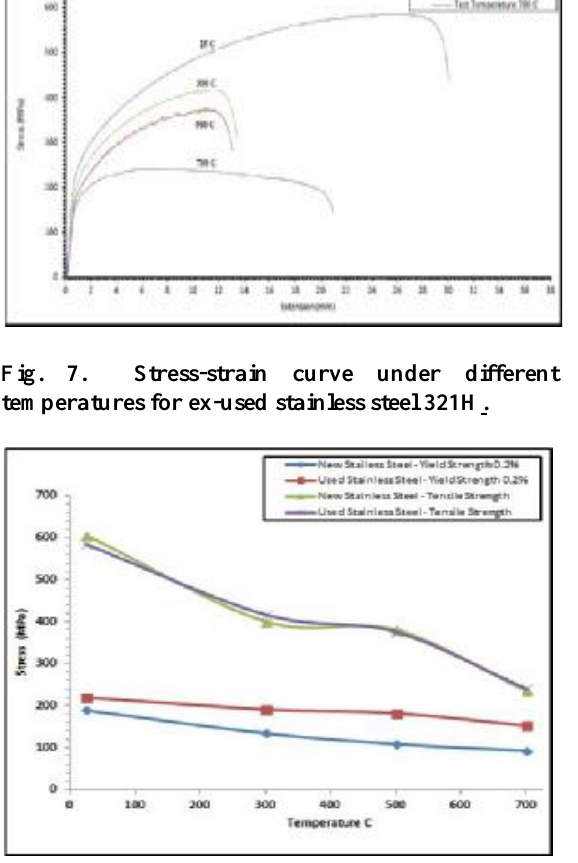
Fig. 8. Yield and tensile strength versus temperature for austenitic stainless steel